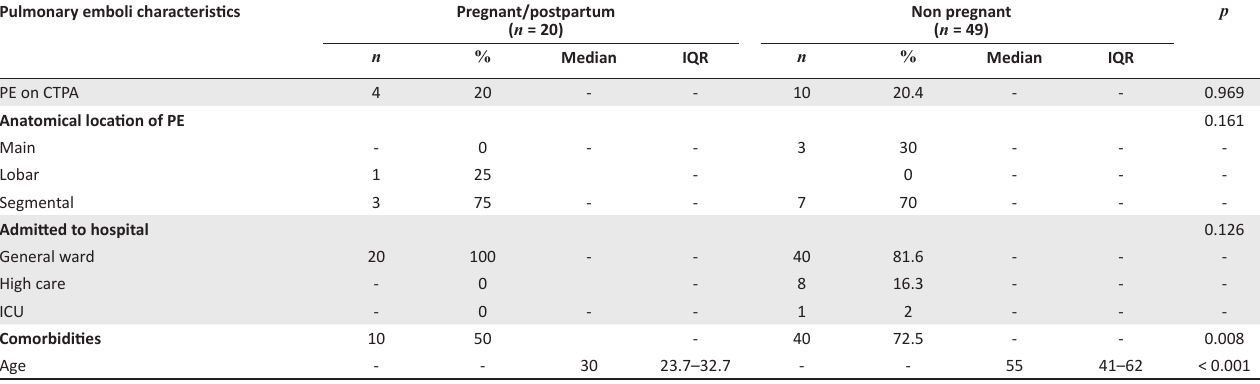
TABLE 4: Pulmonary emboli characteristics between pregnant, postpartum and non pregnant patients. Pulmonary emboli